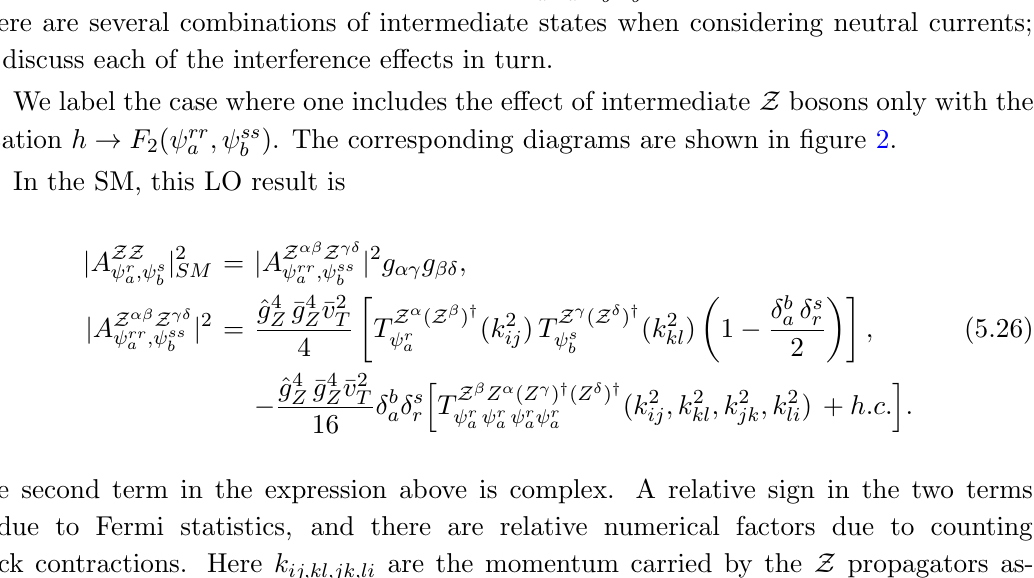
Figure 2 . Pure Z neutral current contributions to h ! 4 . The SM diagrams also represent O ((cid:22) v 2 = (cid:3) 2 ) operator insertions perturbing the SM prediction through diagrams with the same pole T structure as the